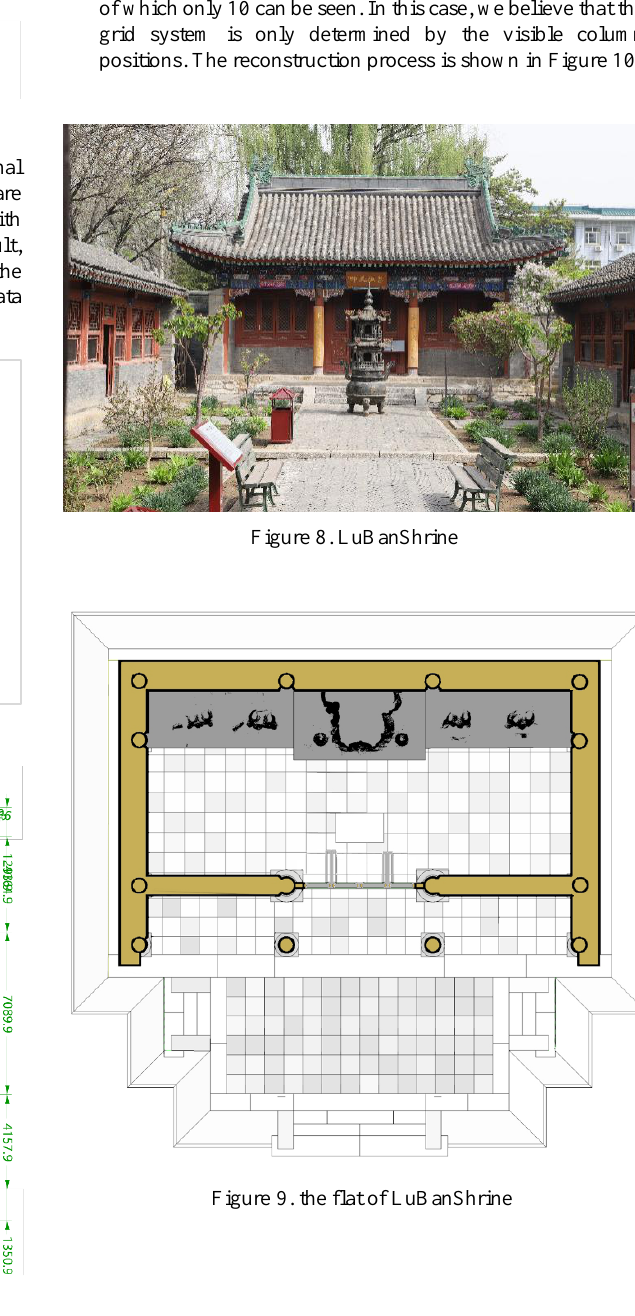
Figure 7. the process of reconstruction of Jingfu Palace